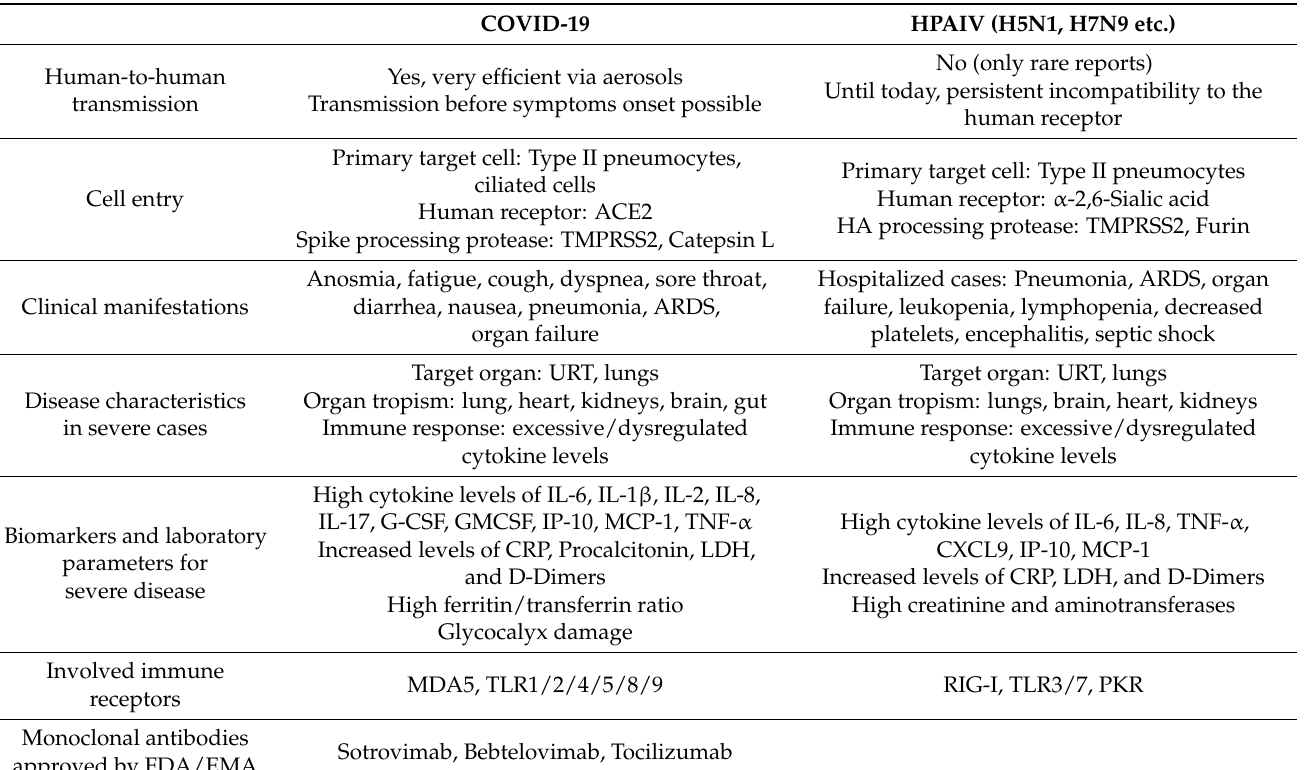
Table 1. Summary of the differences and similarities of COVID-19 and HPAIV-induced